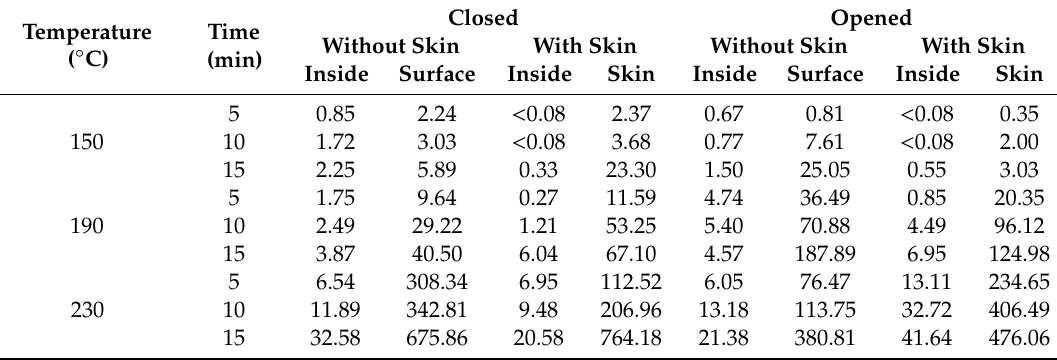
Table 1. Total heterocyclic amine content of the chicken breast samples (ng / g). Temperature